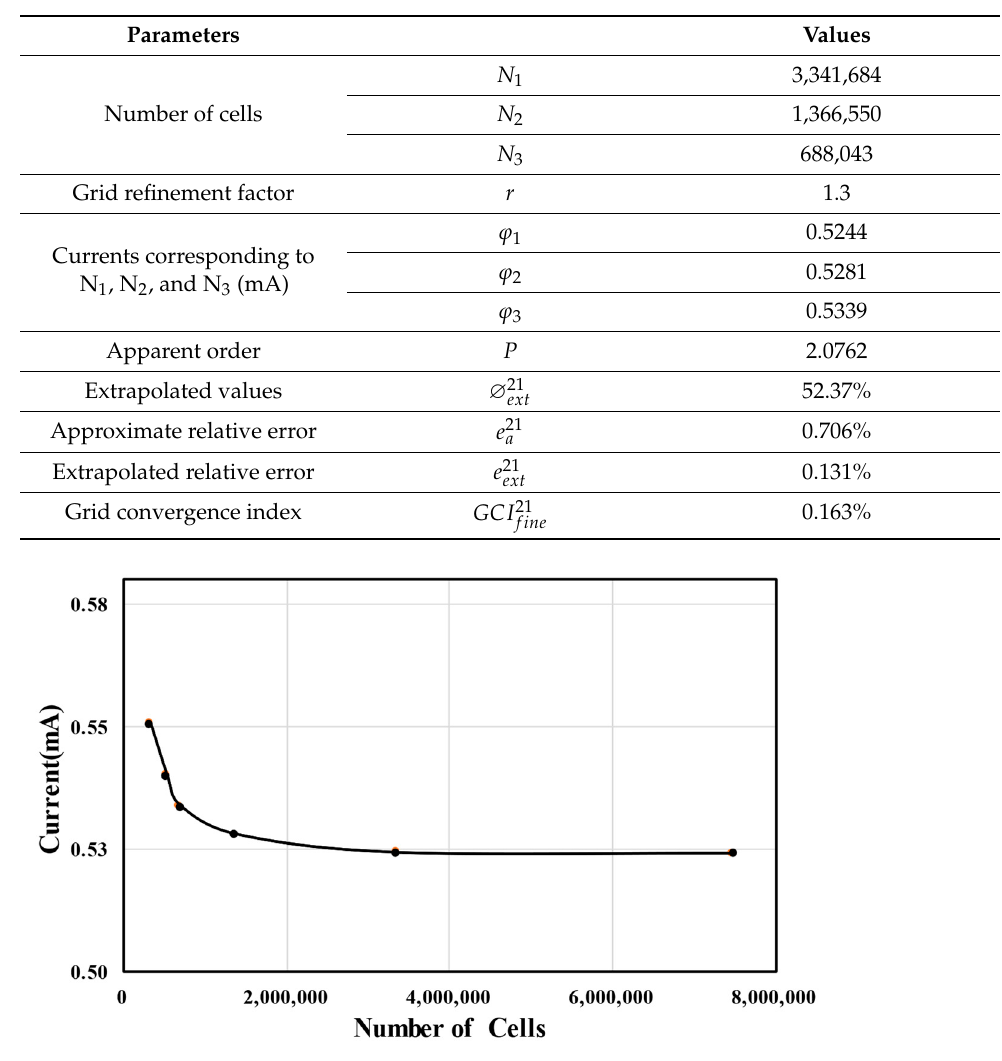
Figure 3. Grid-dependency